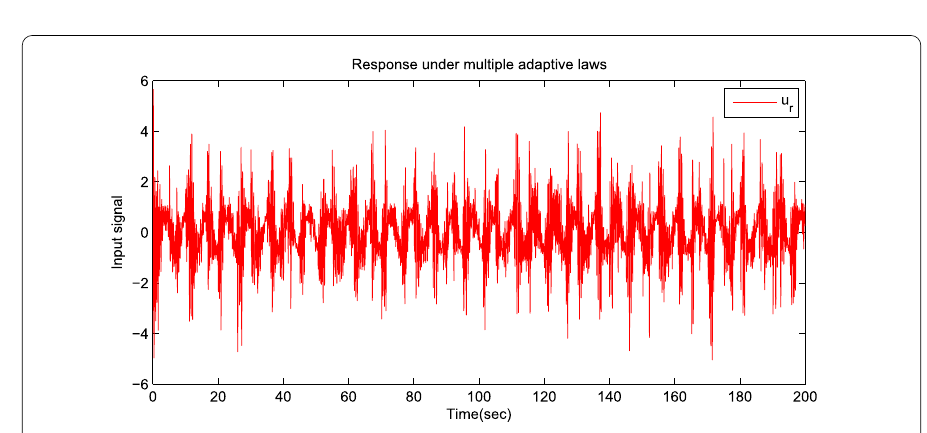
results. Figures 8–10 show that the variables x 2 , u r and ˆ ς are bounded. Figure 11 shows the switching